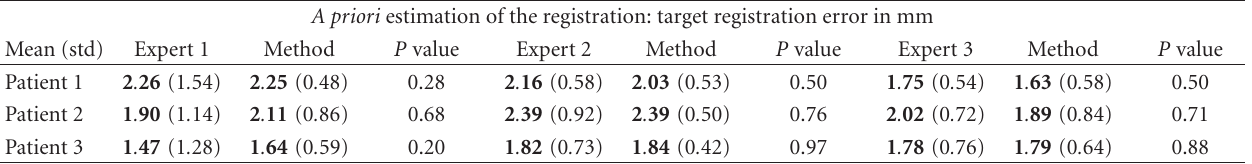
Table 2: Target registration error in mm. The P values correspond to Kruskal-Wallis test performed between the TRE obtained by experts and the TRE obtained with our method.